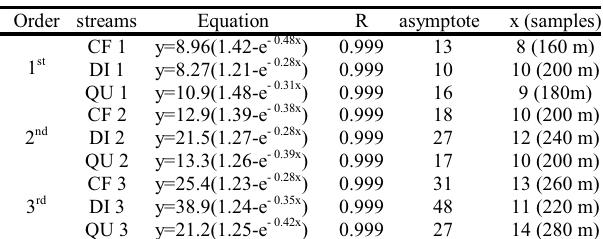
Table 5. Summary of equations of species accumulation curves, linear regression parameters, asymptote values (= estimated number of species) and length of stream segment estimated to result in a complete survey of species at each site. x= num- ber of samples (20-m reaches) necessary to the curve to reach an asymptote.